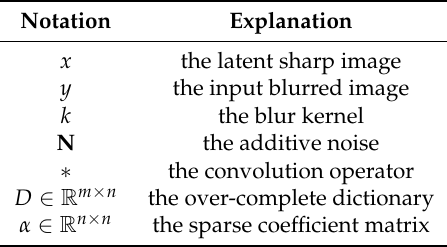
Table 1. Notation and